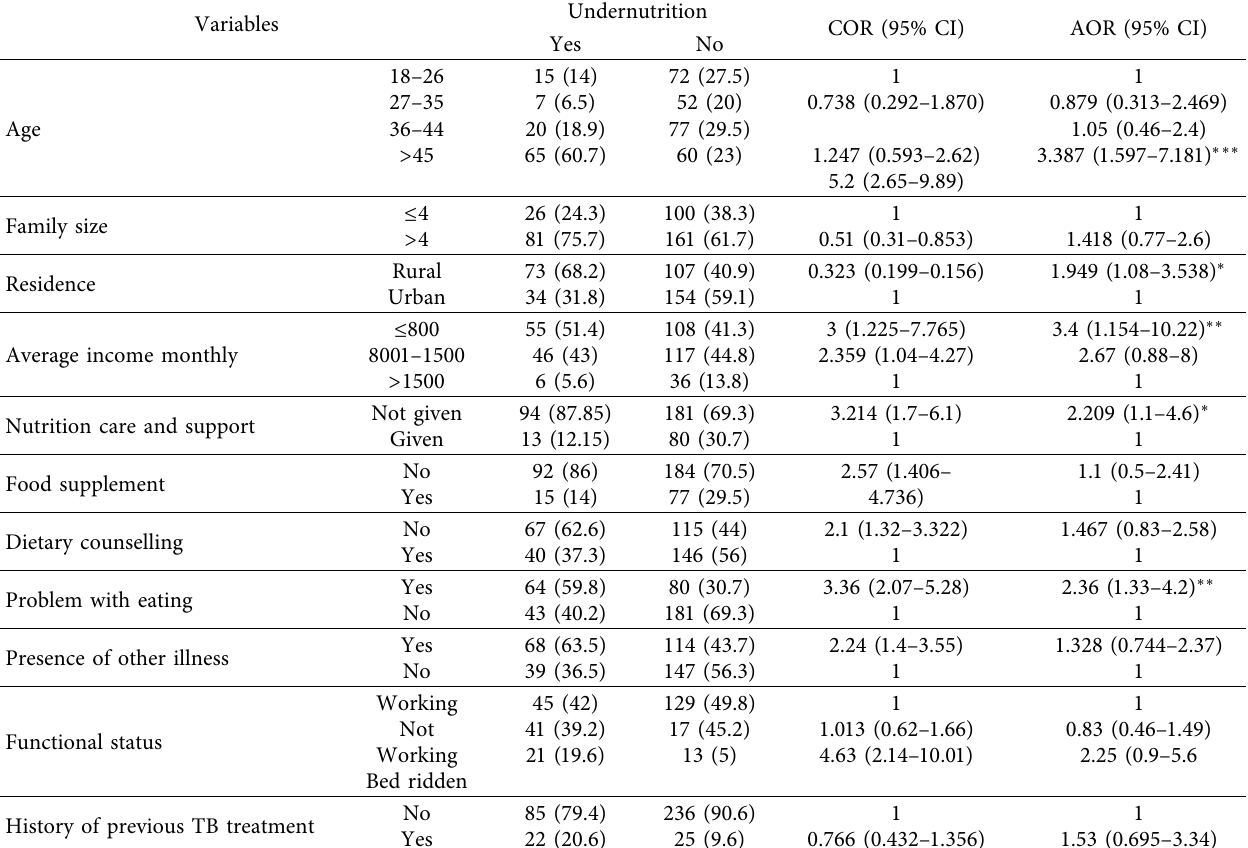
Table 3: Factors associated with undernutrition among adult TB patients in government health institutions of Shashemane, Ethiopia, April 2017 ( n �